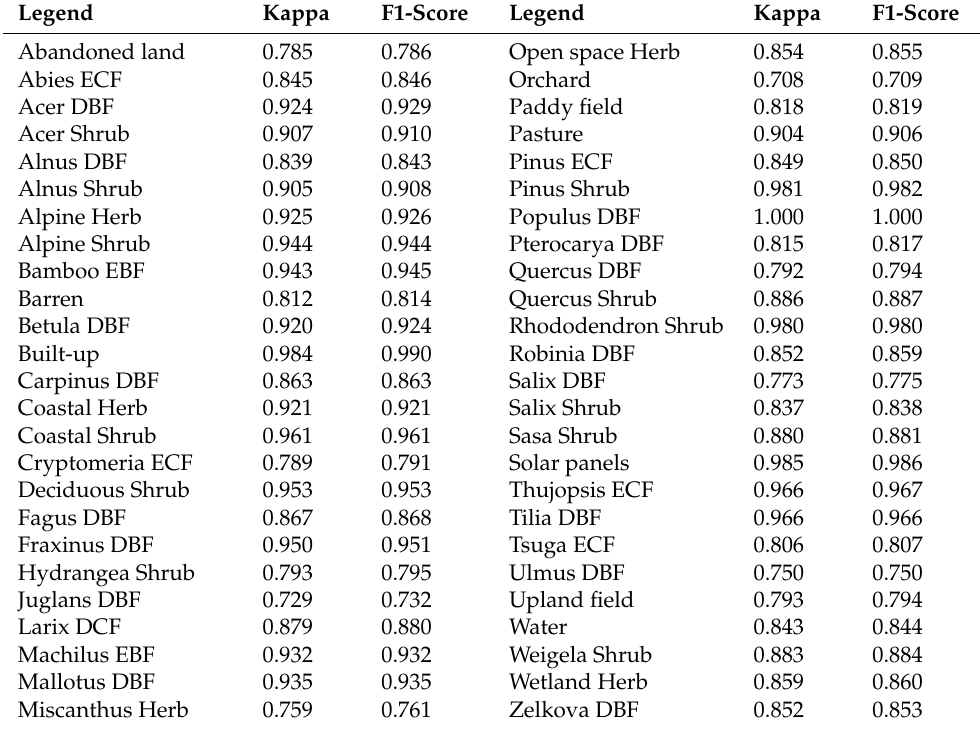
Table 3. Class-wise cross-validation accuracy obtained for Yamagata